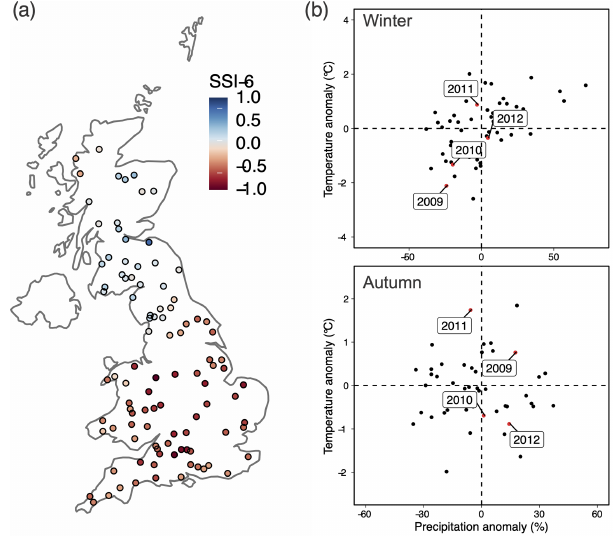
Figure 3. (a) Mean SSI-6 values between January 2010 and March 2012. (b) Yearly winter and autumn precipitation and tem- perature anomalies (relative to 1965–2015) averaged over the 100 selected catchments. The years 2009, 2010, 2011, and 2012 are shown by the red dots, and the rest of the years are shown by the black